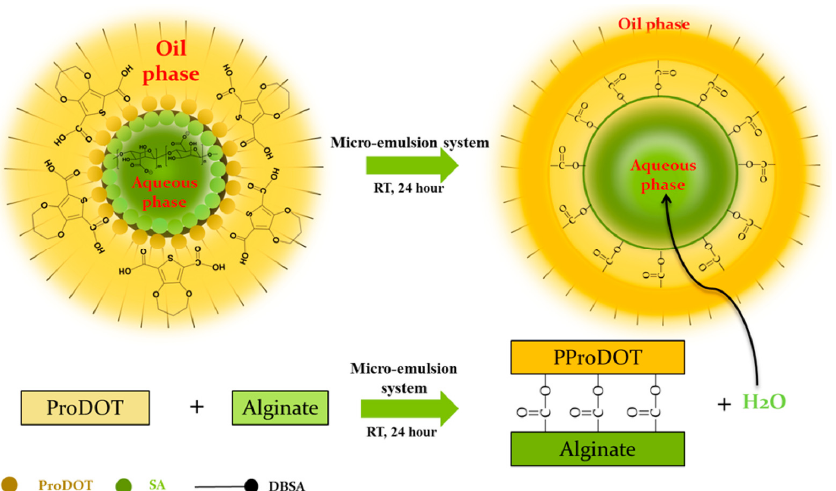
Figure 4. Schematic design of the microemulsion system for synthesis of SA-PProDOT polymer. SA and ProDOT molecules self-assemble along with hydrophilicity of the functional groups, forming an interface where the esterification reaction takes place. The produced water is removed from the interface to the hydrophilic phase, which advances the reaction equilibrium forward [75]. Reprint with permission from [75]; Copyright 2015, American Chemical Society.